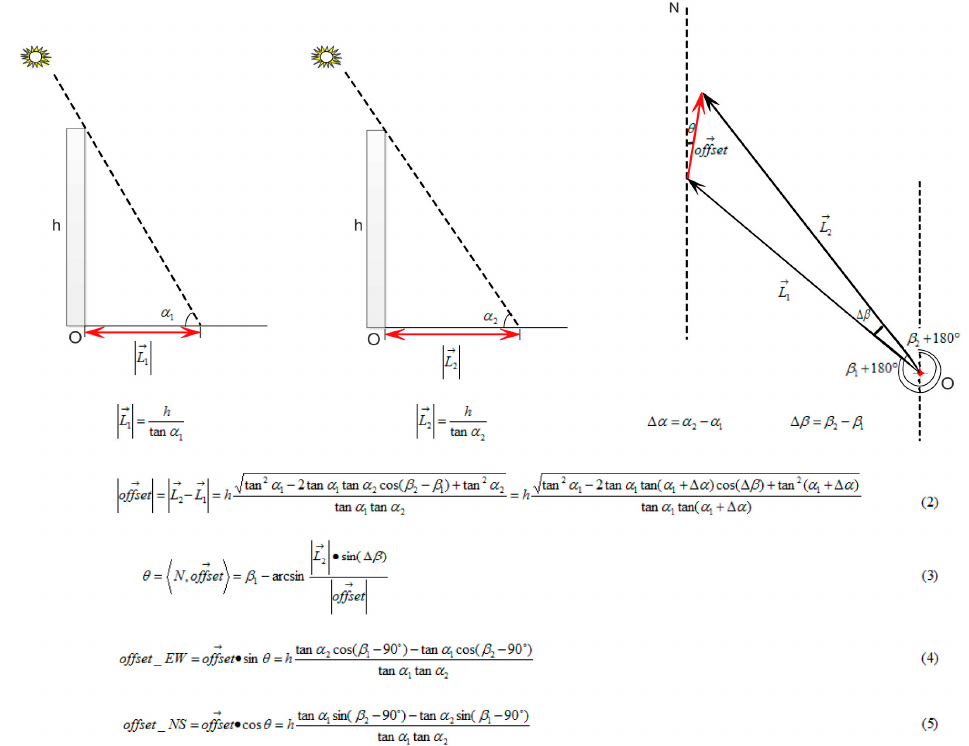
Figure 9. Mechanism of topographic shadowing artifacts. Equations below the figures show how to calculate the magnitude and orientation of the offset caused by shadowing variation. ( α 1, β 1) and ( α 2, β 2) represent the sun elevation and azimuth of pre- and post-event images, respectively. L1 and L2 represent the shadow lengths on a flattish surface of a reference datum named O with height h at the sun elevation of α 1 and α 2, respectively. Equations (2) and (3) show how to calculate the magnitude and orientation θ of vector offset due to shadowing variation, in which ∆α and ∆β denote the sun elevation and sun azimuth disparity, respectively. Equations (4) and (5) represent how to calculate the E/W offset and N/S offset decomposed from the vector offset, and the results are positive toward East and North.